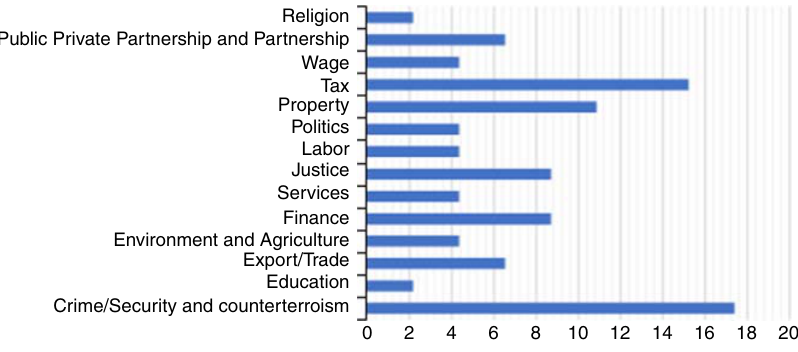
Figure 3. Percentage of